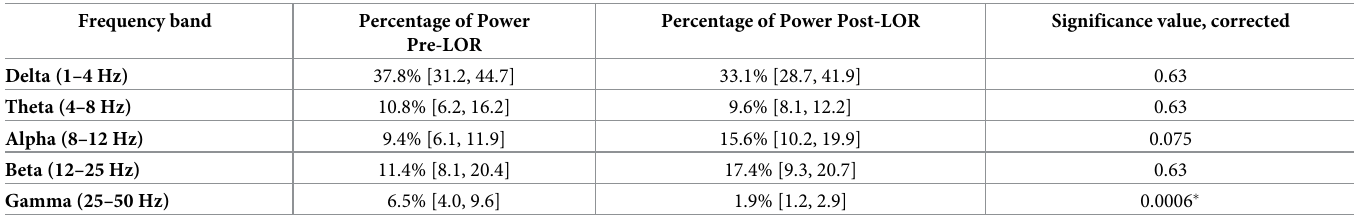
Fig 3. Spectrograms before and after loss and recovery of response. Examples of normalized spectrograms around loss (left) and recovery (right) of response events from four patients. Preceding and following LOR, the pattern of spectral activity is characterized by an increase in power of slow-wave activity, termed slow-wave anesthesia18, in both the delta (1–4 Hz) and alpha (8–12 Hz) bands; a predominant alpha rhythm is particularly noticeable. This transition emerges slowly during the LOR period, and with a variable time-course for each patient. In contrast, the period of emergence from general anesthesia to ROR is marked by a more uniform distribution of power across frequency bands, and the previously dominant alpha rhythm is replaced by a more pronounced beta rhythm. In the 4 patients shown, this transition appears to be more abrupt than the trajectory toward LOR. https://doi.org/10.1371/journal.pone.0223921.g003 Table 1. Summary of spectral changes from before and after loss of response